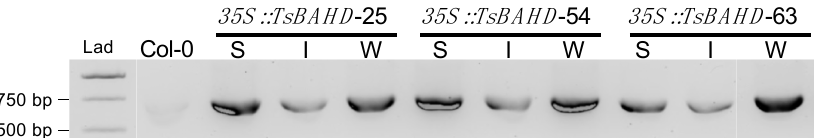
Figure 2. Confirmation of insert in transgenic lines in A. thaliana . Three independent lines of the TsBAHD overexpression construct. Each 35S::TsBAHD line has been confirmed in severe (S), intermediate (I), and weak (W) dwarf phenotypes, represented by the three bands under each 35S::TsBAHD line in corresponding order. Expected fragment size is 683 bp. Each lane contained 5 µ L of PCR product and 2 µ L of loading dye. LAD was 5 µ L of a 1 kb DNA ladder.